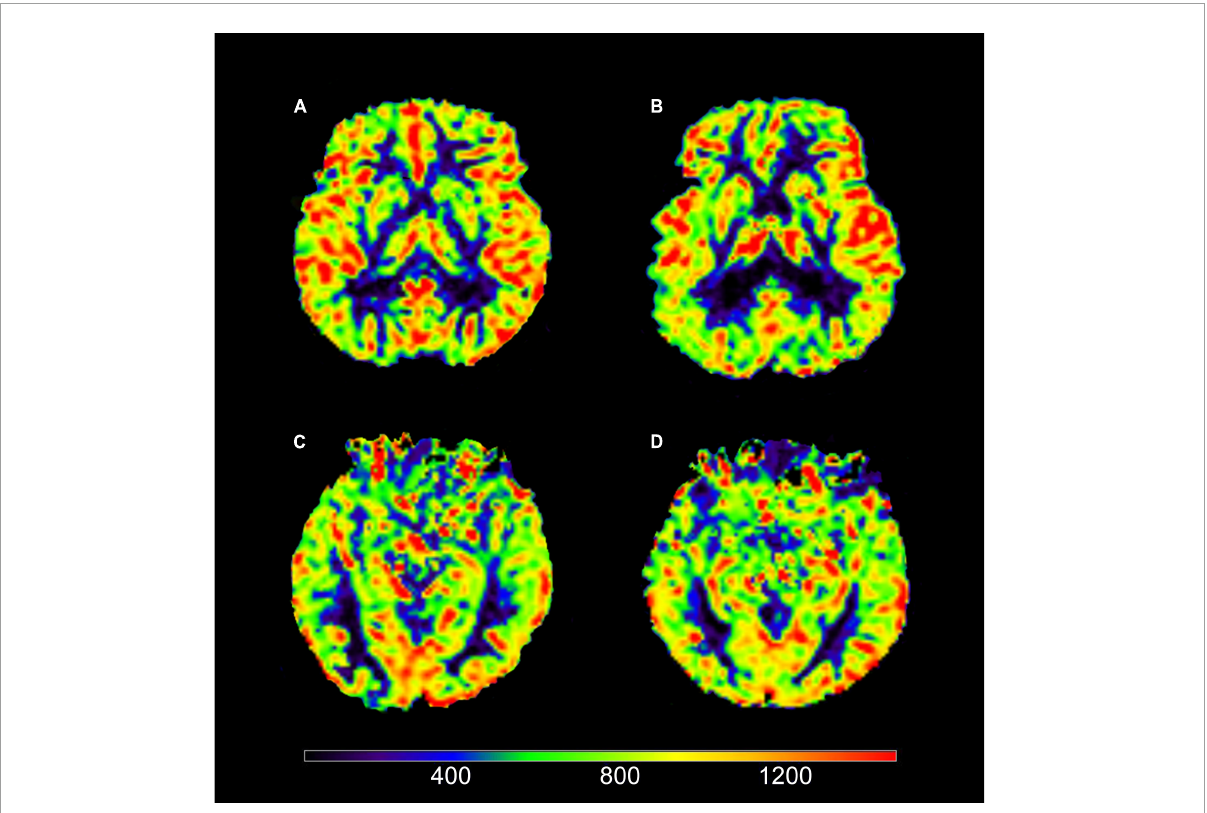
FIGURE2 Axial view of cerebral blood flow (CBF). (A) Image of a typical AD patient (female; 67 years old). (B) Image of a NC subject (male; 73 years old). (C) Image of a typical AD patient (female; 64 years old). (D) Image of a NC subject (female; 64 years old). It could be intuitively shown that (A) views had decreased CBF in right caudate nucleus (RCc) compared to (B) views; (C) views had decreased CBF in left hippocampus (LHc) compared to (D)